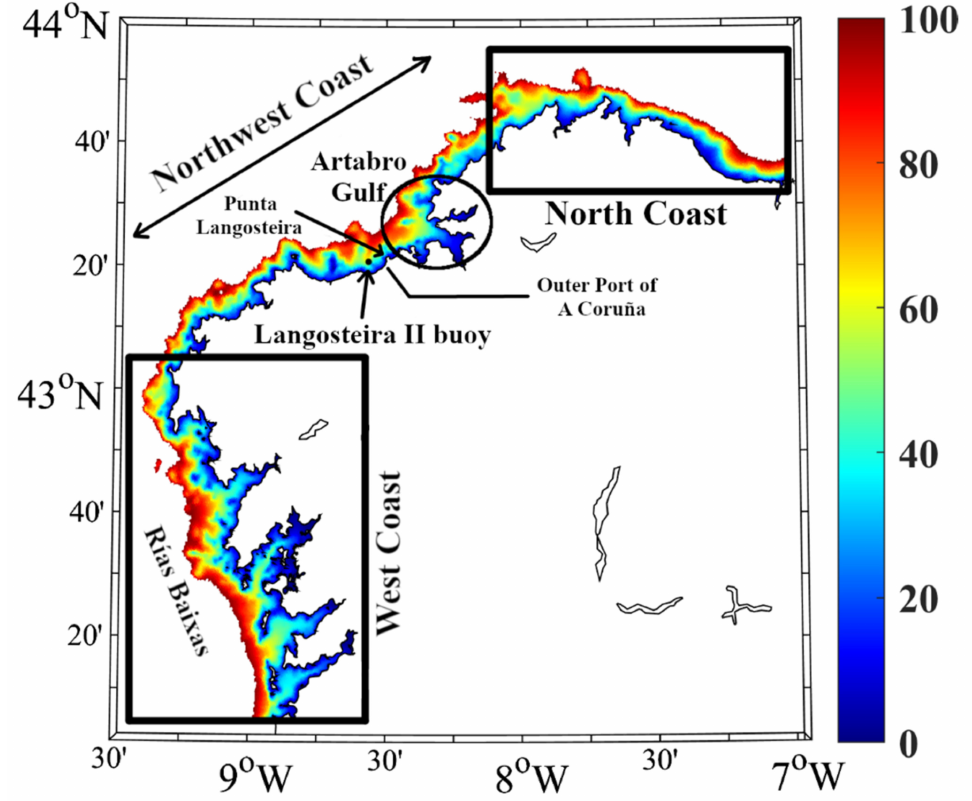
Figure 1. Study area. Colors represent the bathymetry